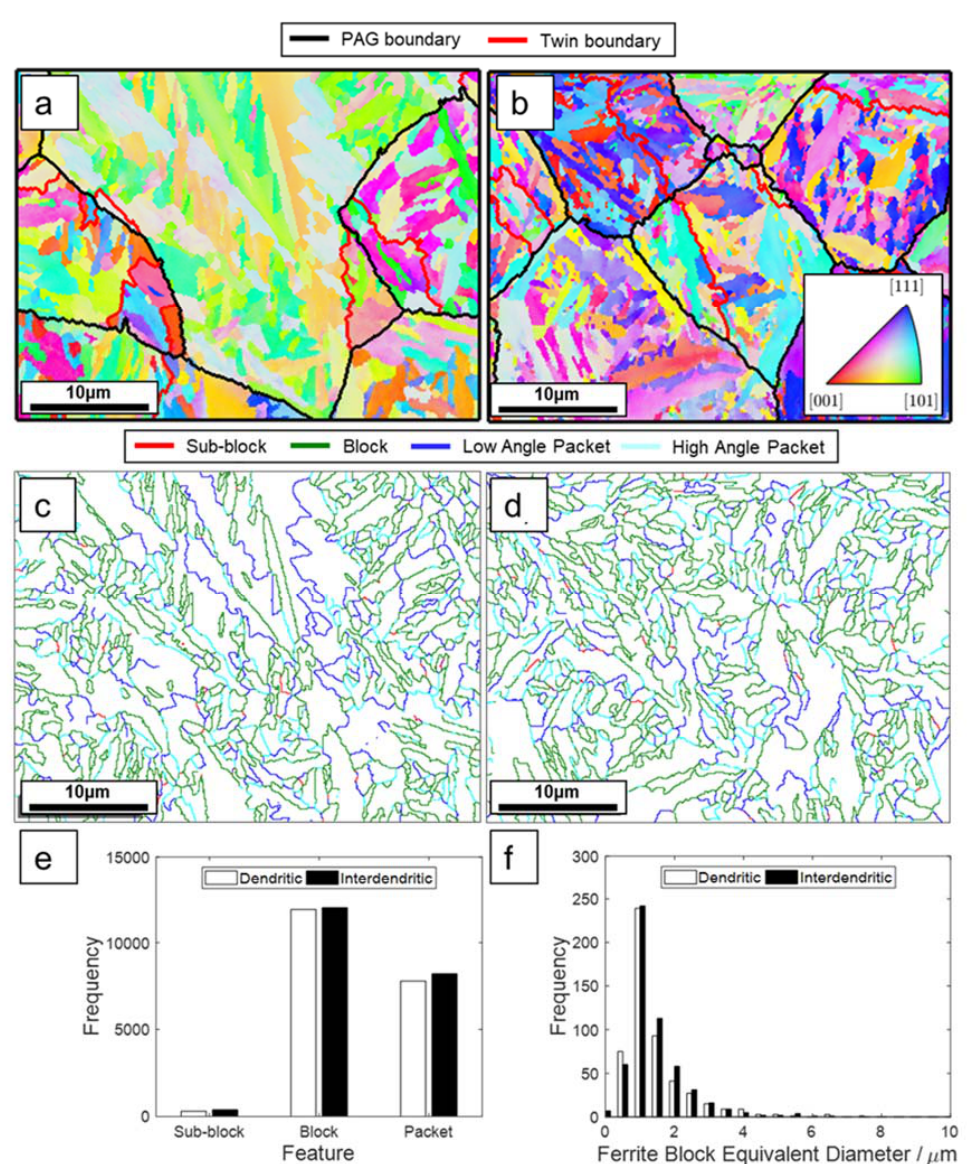
Figure 11. ( a , b ) Ferrite IPFZ maps for dendritic and interdendritic regions, respectively, where the prior austenite grains boundaries (PAGB) are represented by black lines, and the red lines are the twin boundaries. Note that all pixels seem to be ferritic as the data has been subjected to noise reduction techniques for a cleaner representation. ( c,d ) EBSD misorientation maps for dendritic and interdendritic regions, respectively; ( e ) Frequency chart showing the frequency of the different types of boundaries characteristic of sub ‐ blocks, blocks and packets; ( f ) Frequency histogram showing the ferrite block equivalent diameter frequency for both dendritic and interdendritic areas. Finally, the regions were compared in terms of the martensitic boundary misorientations frequency and ferrite (martensite) block sizes. To do so, it has been assumed that the OR remains constant along the steel of study, i.e. <0.14 0.17 0.98> 44.08° using the axis/angle pair convention. This